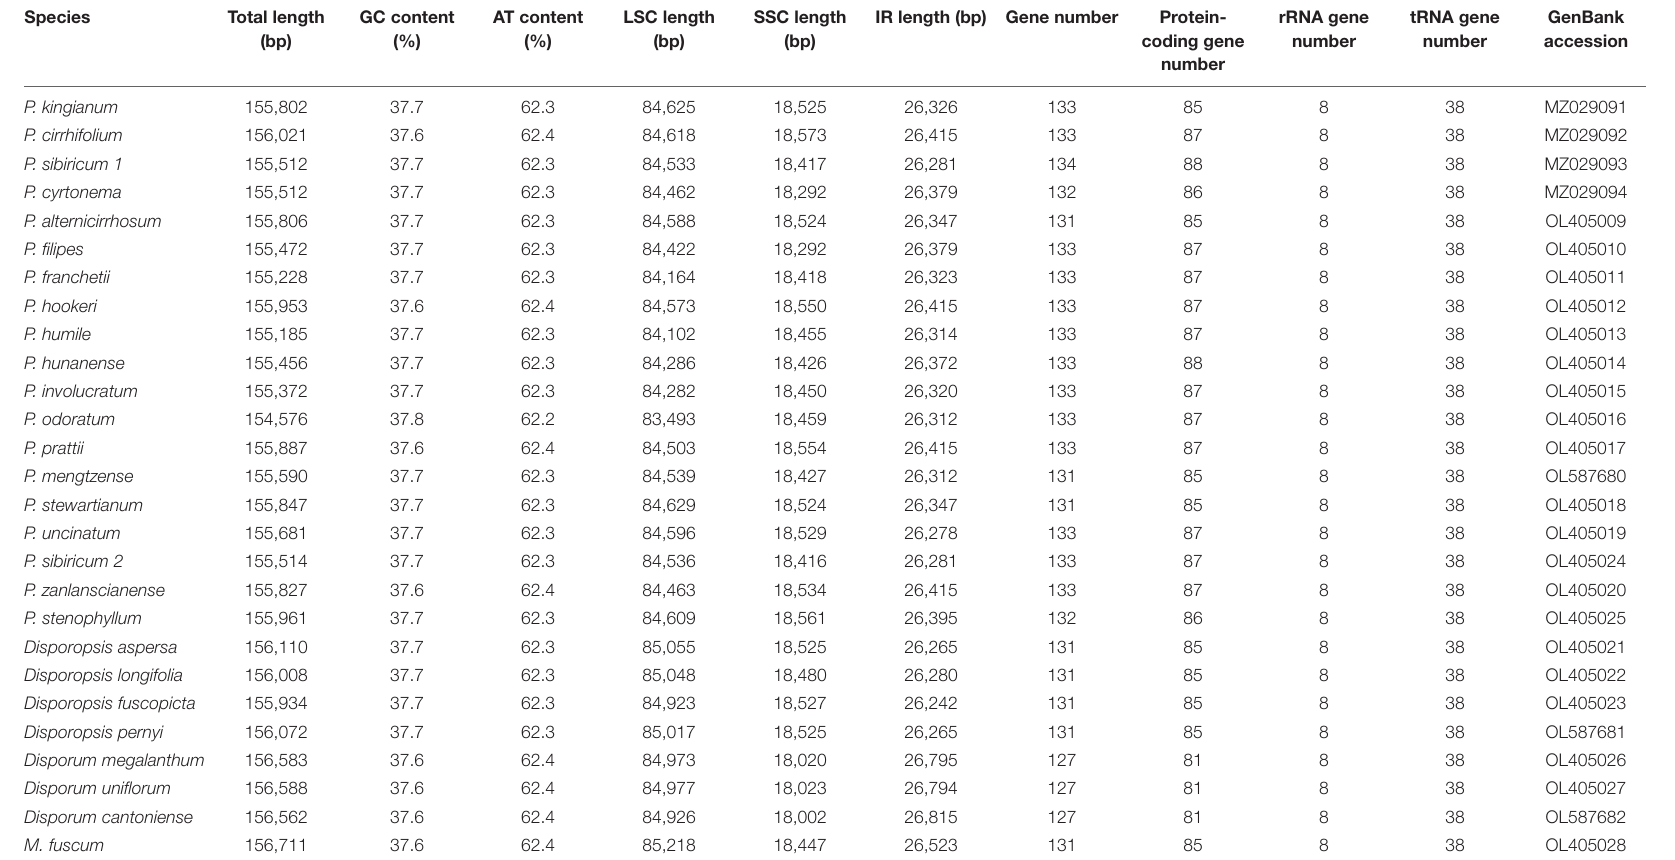
TABLE 1 | Summary of cp genome